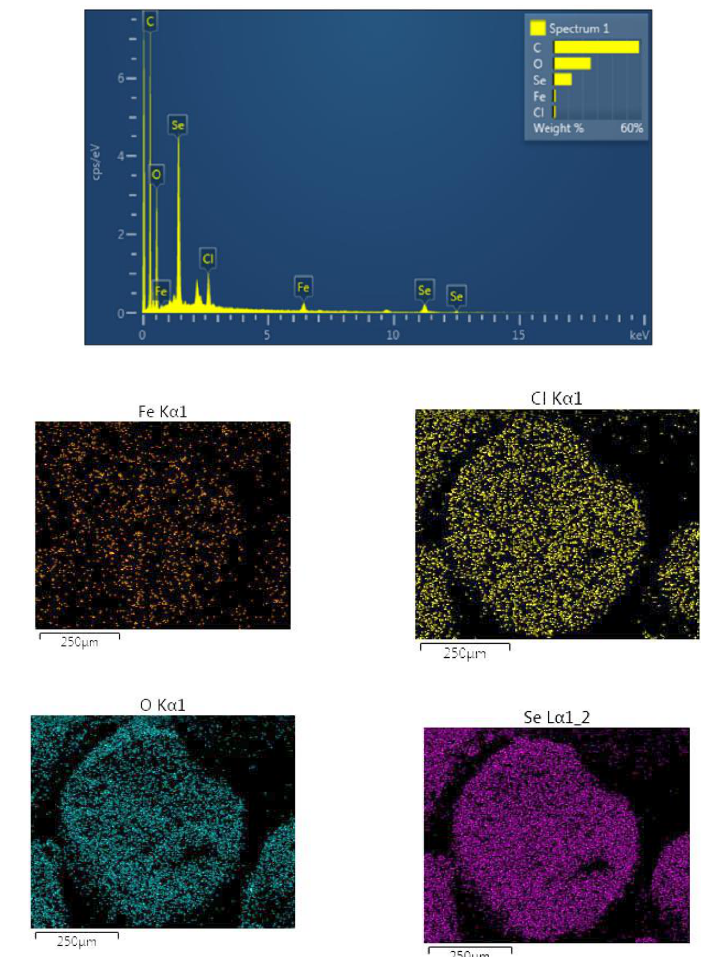
Figure 9. EDS image with map of element distribution of the A-LMS Fe 3 O 4 /Se adsorbent.